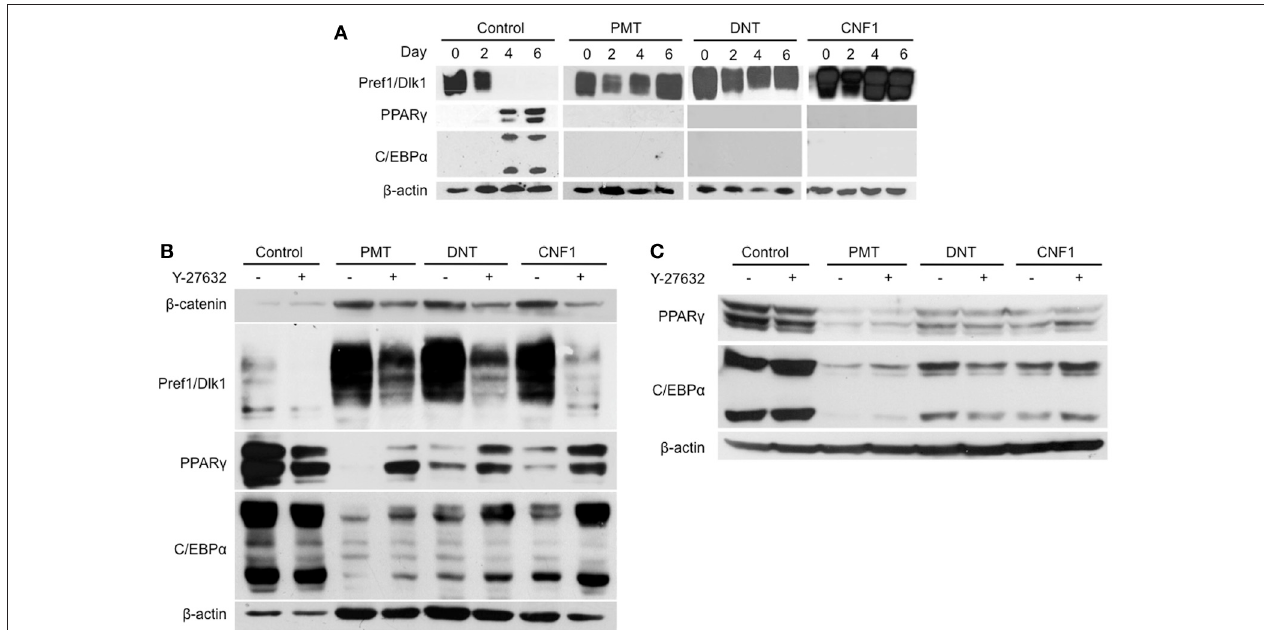
FIGURE 3 | Effect of dermonecrotic toxins on adipocyte marker expression profiles during differentiation. Confluent 3T3-L1 preadipocytes were induced to differentiate in DM, as described in Materials and Methods. On the indicated days, cell lysates were subjected to SDS-PAGE and immunoblot analysis using antibodies against β -catenin, Pref1/Dlk1, PPAR γ , C/EBP α , or β -actin. (A) Time-course of differentiation in the absence (control)